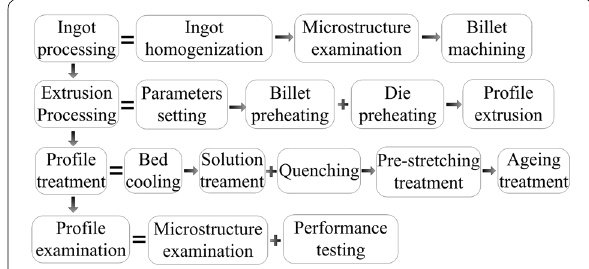
Figure 3 Common processes for producing the Al–Li alloy extrusion profiles